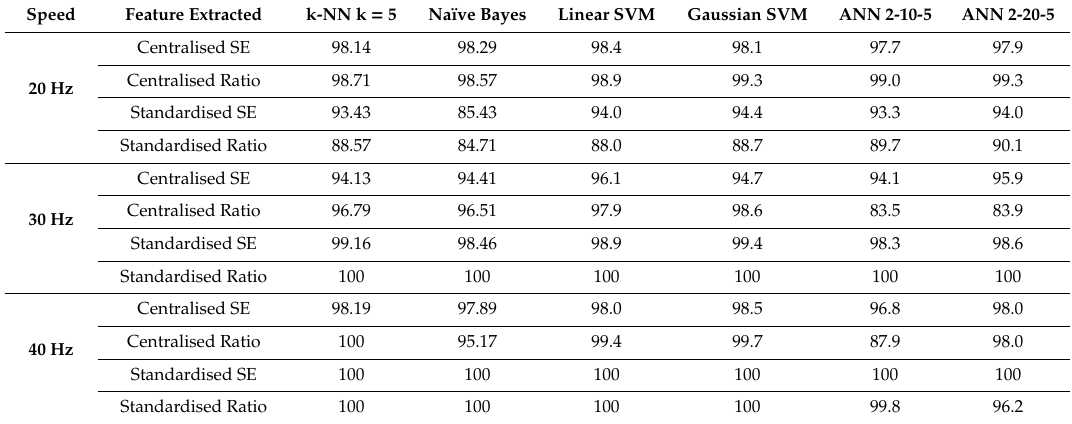
Table 4. Accuracy of di ff erent machine learning classifiers